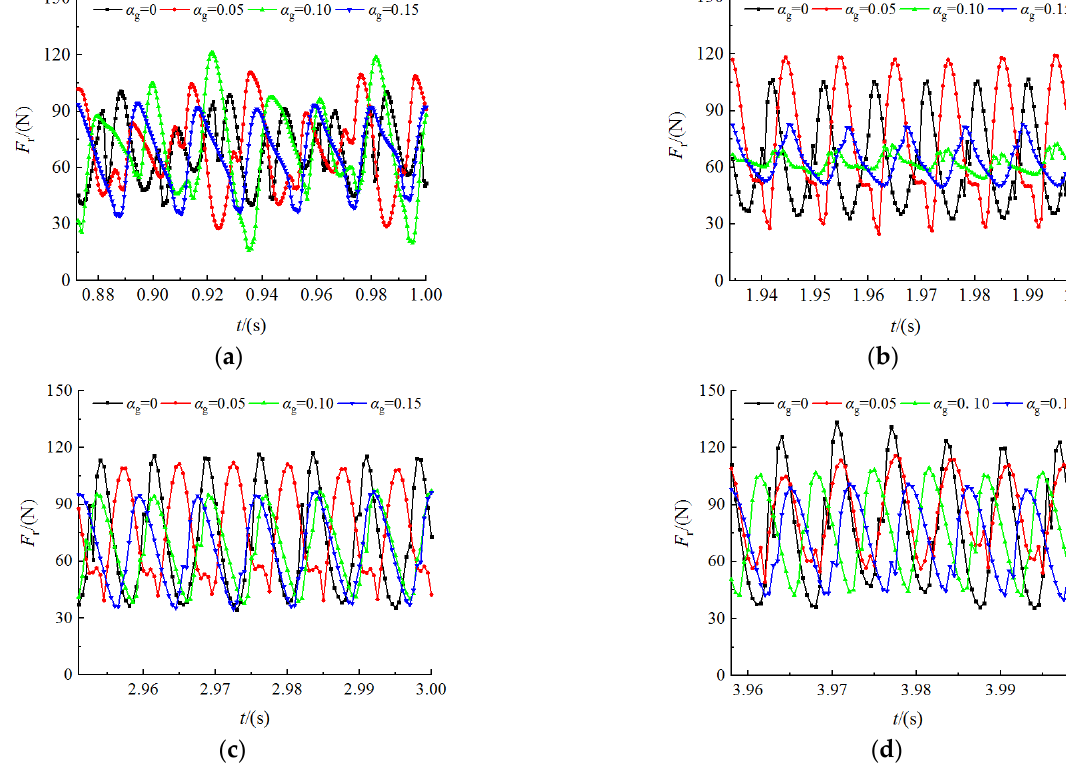
Figure 12. Time domain characteristic of radial force during the start-up process. ( a ) t = 1 s; ( b ) t = 2 s; ( c ) t = 3 s; ( d ) t = 4 s.